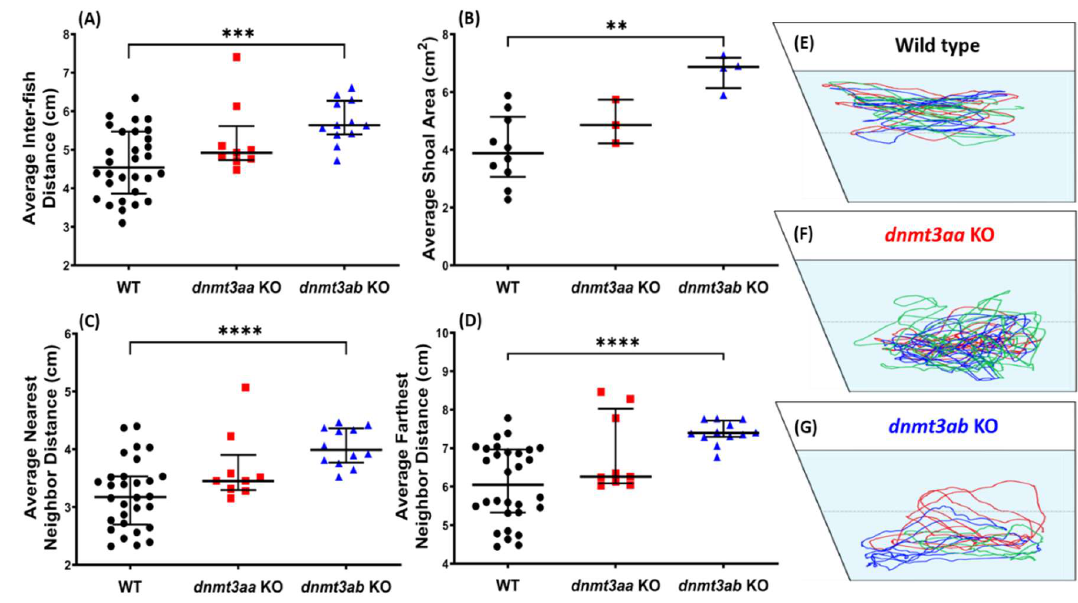
Figure 7. Comparison of shoaling behavior endpoints among the wild-type, the dnmt3aa , and the dnmt3ab mutant fish. ( A ) Average inter-fish distance, ( B ) average shoal area, and ( C ) average nearest neighbor distance, and ( D ) average nearest neighbor distance were analyzed. Three fish were used in one group (shoal) for the shoaling test. The data are expressed as the median with interquartile range and analyzed by Mann–Whitney test ( n = 30 for wild type; n = 9 for dnmt3aa KO fish; n = 12 for dnmt3ab KO fish; ** p < 0.01, *** p < 0.001, ****, p < 0.0001). ( E – G ) The locomotion trajectories of three fish of the wild type, the dnmt3aa KO, and the dnmt3ab KO fish, respectively, during the shoaling test.